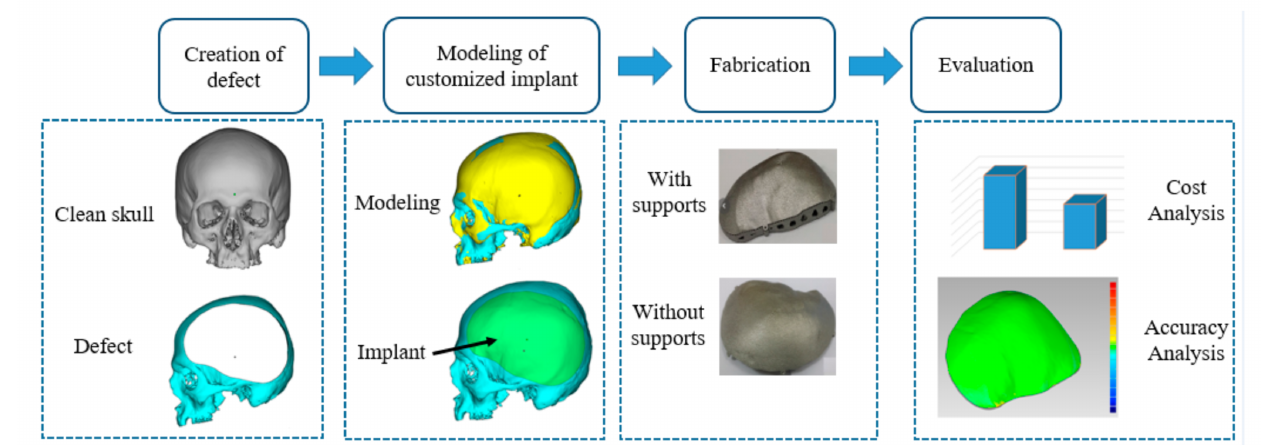
Figure 1. Process flow of adopted methodology.